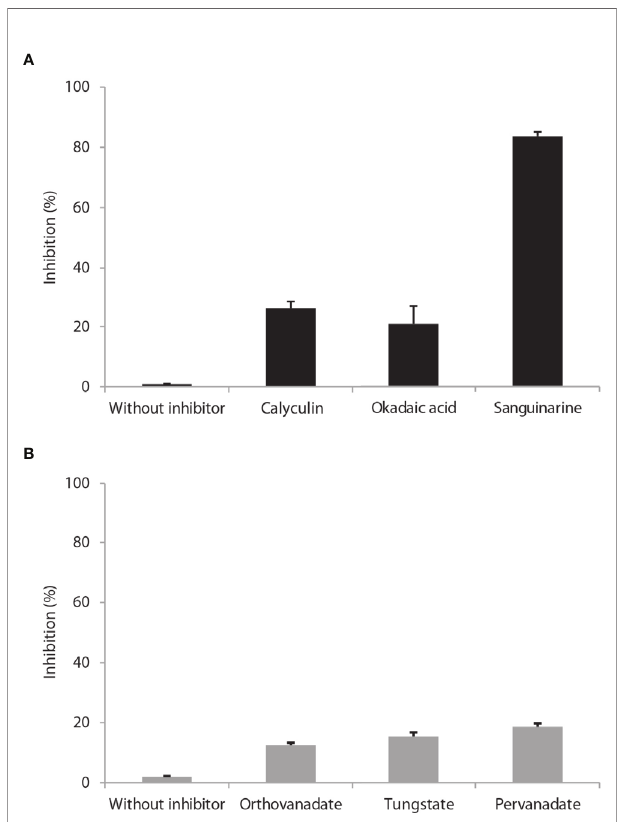
FIGURE 4 | Effect of different inhibitors on PP2C of Leishmania mexicana . (A) Inhibitors (calyculin and okadaic acid) of serine threonine phosphatases and an inhibitor (sanguinarine) of the PPM family were incubated with PP2C of L. mexicana ( Lmx PP2C), and then phosphatase activity was assessed with p -NPP as the substrate. (B) Inhibitors of PTPs (orthovanadate, tungstate and pervanadate) were incubated with L mx PP2C and then phosphatase activity was evaluated with p -NPP as the substrate. Bars represent the mean percentage of relative activity of three independent performed on the MAFFT program. The colored boxes display the the four aspartate residues that are crucial in the catalytic activity.